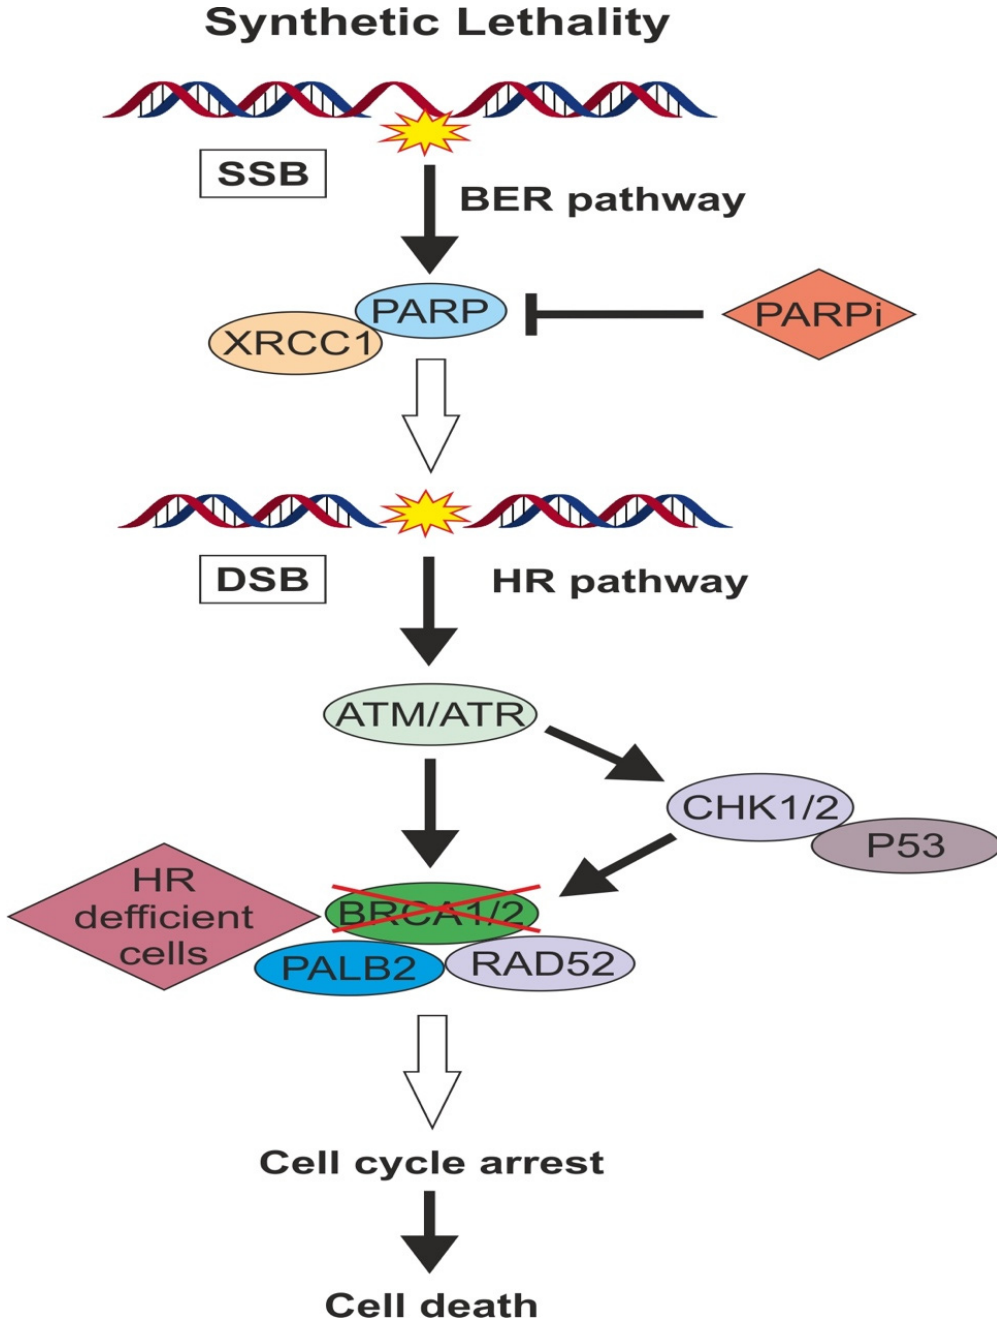
Figure 1. When replication fork comes upon DNA SSBs, it is very likely to collapse and generate DSBs requiring the involvement of HR pathway to repair them.